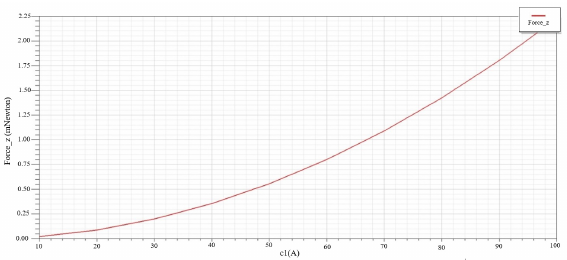
Fig. 8. Influence of current on axial stress of shaft